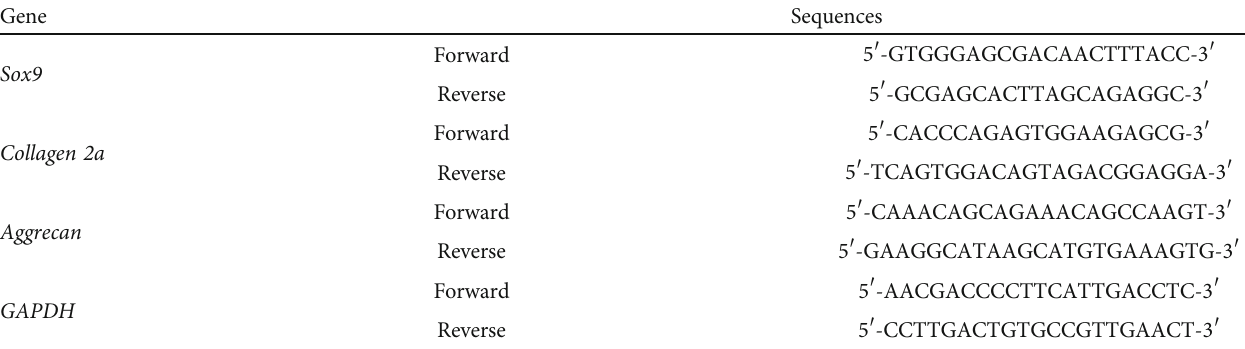
Table 1: The information of